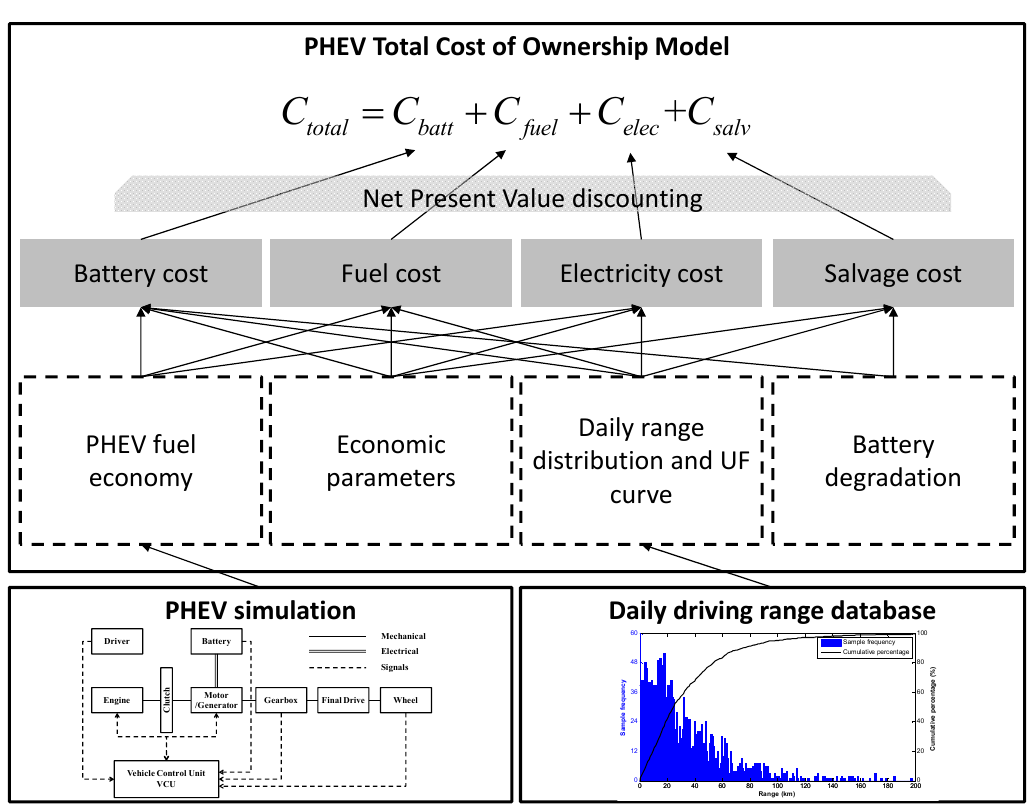
Figure 1. The TCO model